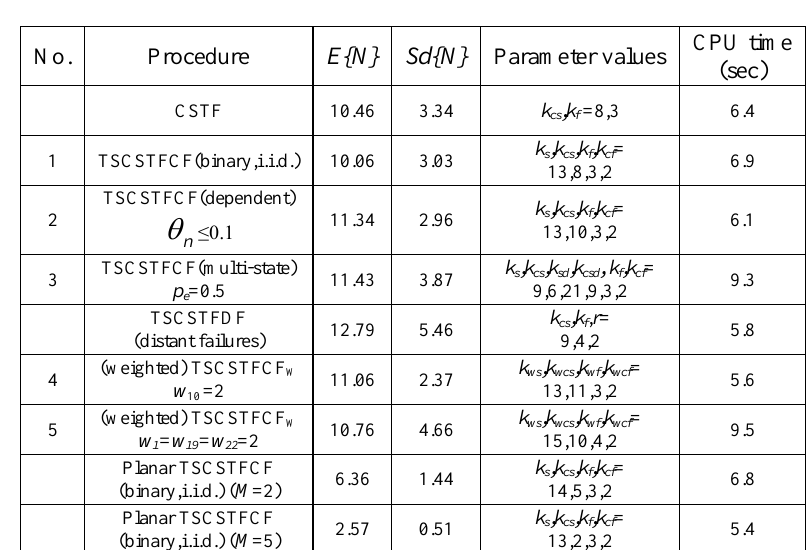
Table 6. Optimal values of the expected number of tests for different procedures